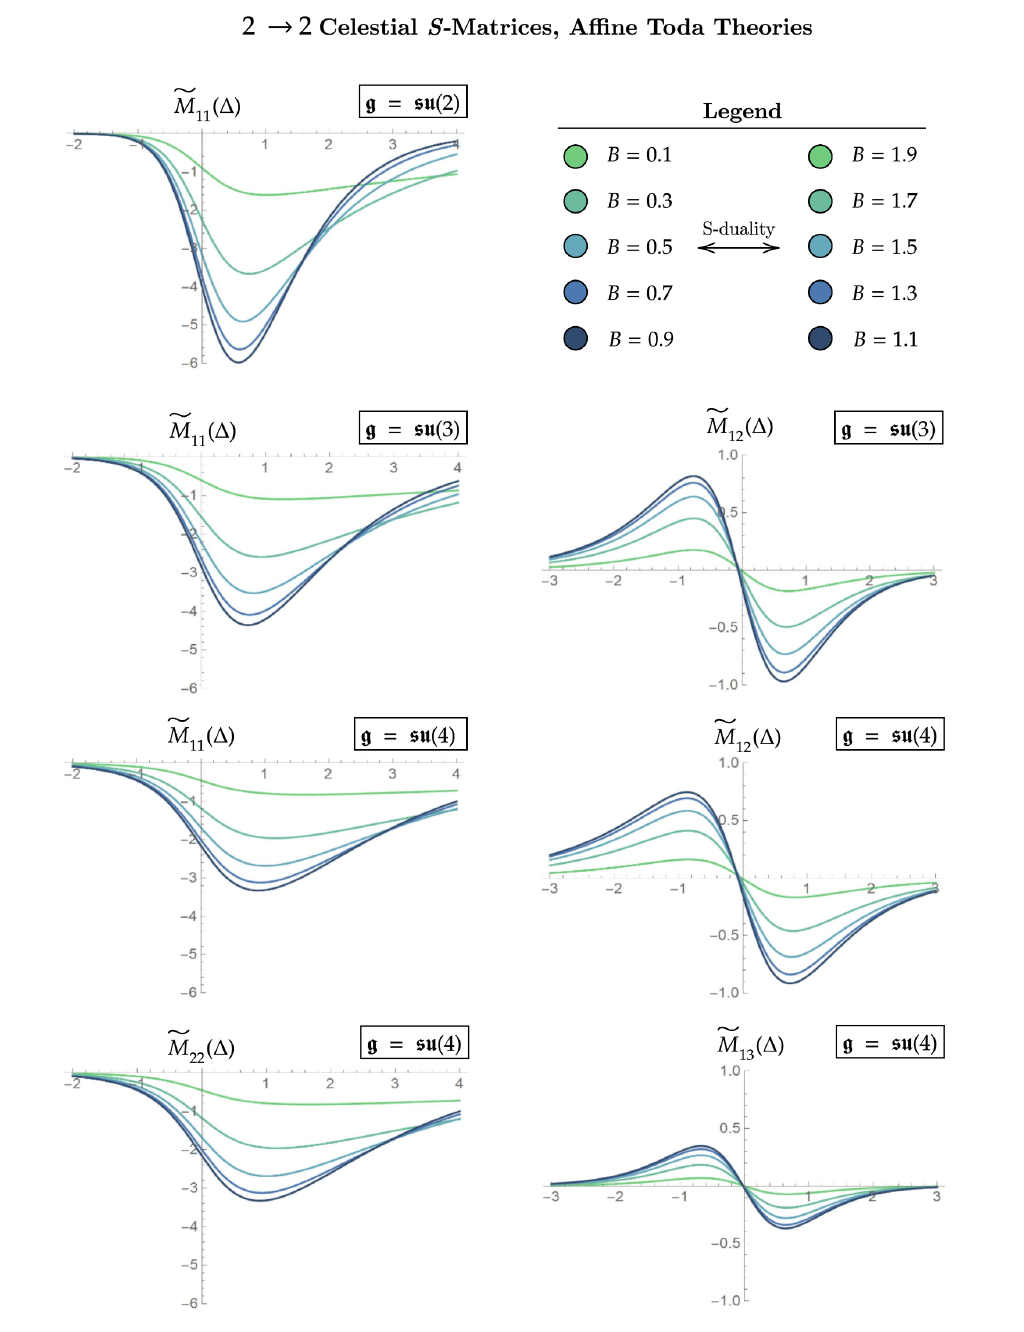
Figure 2 . Plots of the Celestial S -matrices for the g = su (2) , su (3) , and su (4) affine Toda theories suppressing the A ij (∆) = 2 πδ (∆) term. The celestial S -matrices satisfy f M ij (∆) = f M ji (∆) ; more- over, f M 11 (∆) = f M 22 (∆) for the su (3) theory while f M 11 (∆) = f M 33 (∆) and f M 12 (∆) = f M 32 (∆) for the su (4) theory just as in the case of the deformed coset